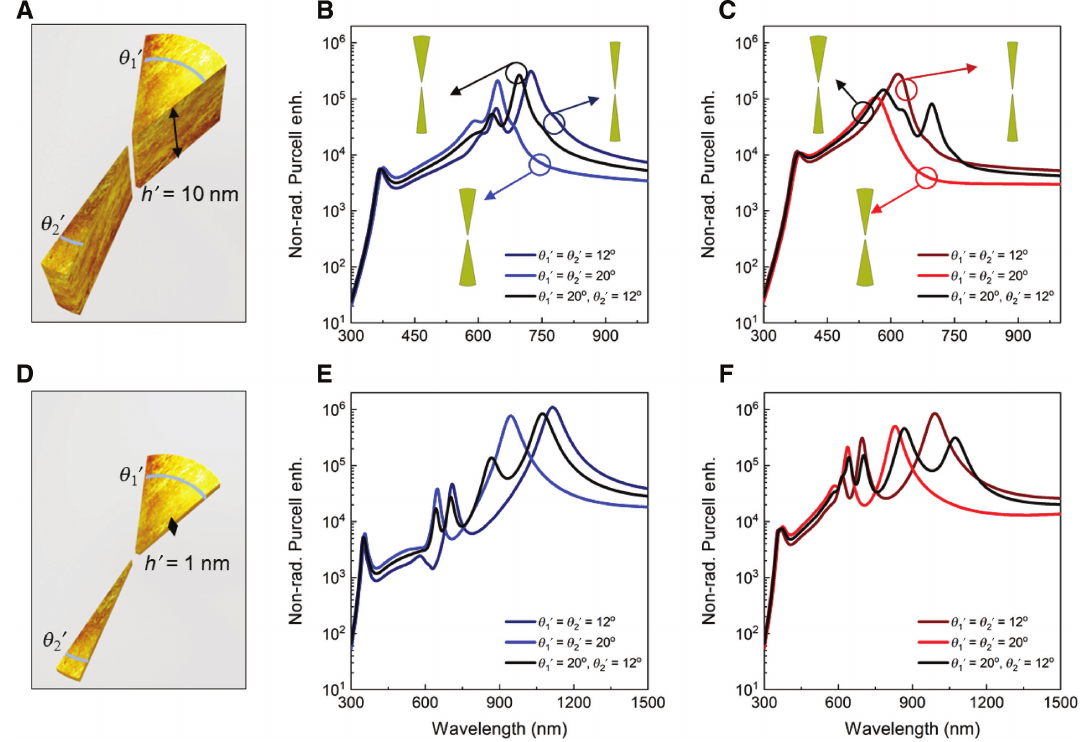
Figure 5: 3D asymmetric bowtie nanoantennas excited by a localized emitter. The schematic representation of the 3D l ′ = 20 nm and g ′ = 1 nm bowties (A, D). The Γ the vertical (second column) and horizontal nanoemitters (third column) for the 10-nm thick (top row) and 1-nm thick bowtie (bottom